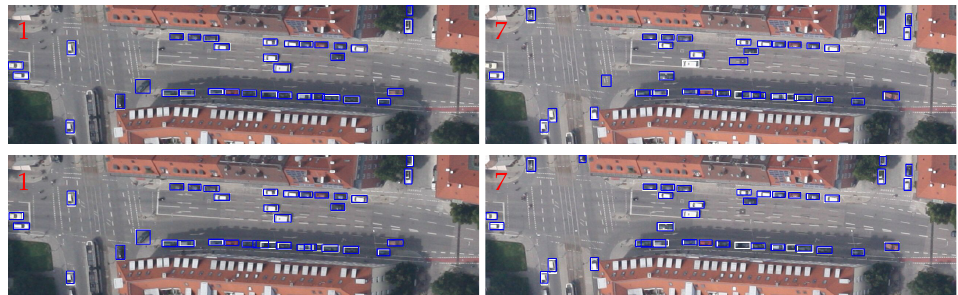
Figure 21. Tracking results by AerialMPTNet ( top row ) and SMSOT-CNN ( bottom row ) on the frames 1 and 7 of the “MunichStreet02” sequence of the KIT AIS vehicle dataset. The predictions and ground truth bounding boxes are depicted in blue and white, respectively.